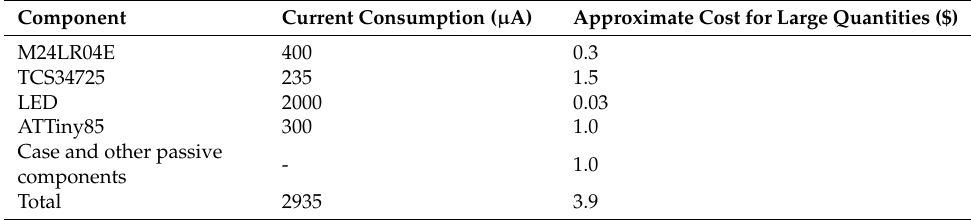
Table 1. Current consumption and components cost.